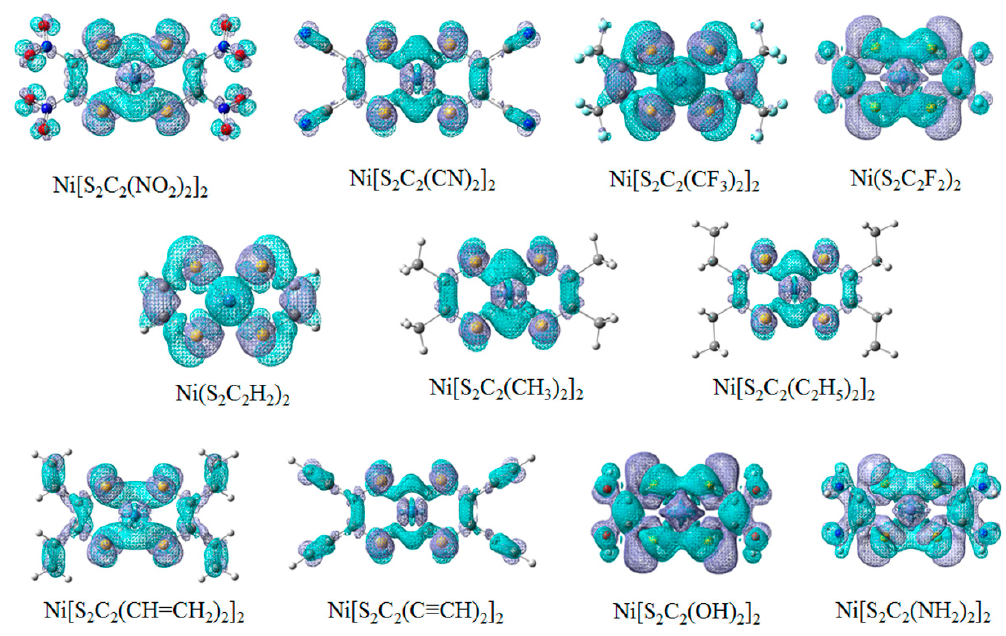
Figure 2. The electron density of Ni(S 2 C 2 R 2 ) 2 (R =–NO 2 , –CN, –CF 3 , –F, –H, –CH 3 , –C 2 H 5 , –CH=CH 2 , –C ≡ CH, –OH, –NH 2 ) in the ground state and the first excited state. The electron density is in the unit of e/Å 3 . S is represented as yellow ball; Ni is represented as light blue ball; N is represented as dark blue ball; C is represented as gray ball; H is represented as white ball; O is represented as red ball.